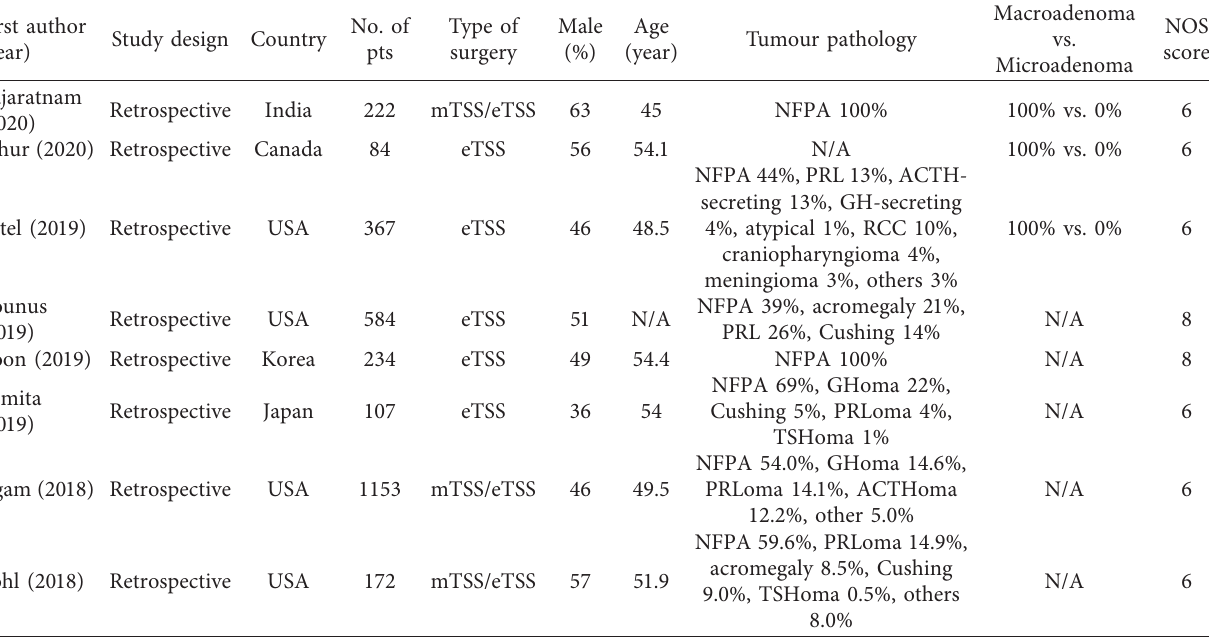
Figure 1: PRISMA flow diagram of study selection. The number of search hits corresponding to each step of the systematic literature search, qualitative review, and quantitative analysis is shown. The reasons for search hit exclusion are Table 1: Summary of demographics of selected studies.